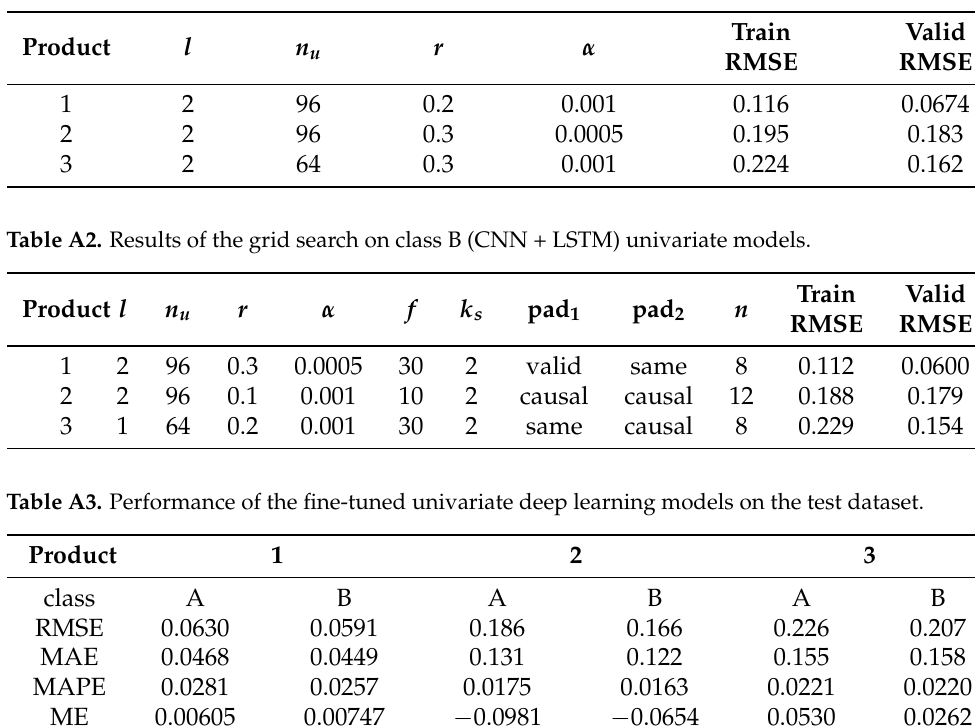
Table A1. Results of the grid search on class A (LSTM-only) univariate models.